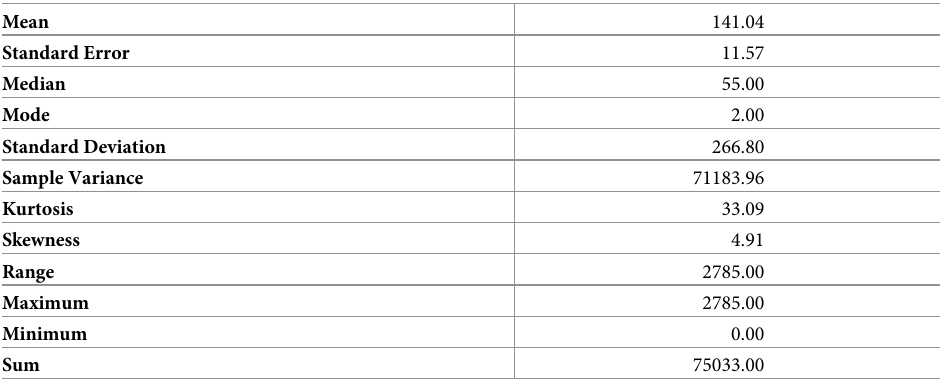
Table 1. SCPP descriptive statistics